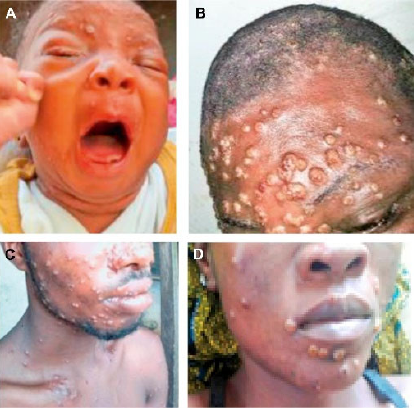
Figure 1. ( A – D ) Maculo ‐ papular ‐ vesicular ‐ pustular monkeypox skin lesions of varying sizes on the face. (Courtesy of Nigeria Center for Disease Control, Abuja, Nigeria.) Reprinted with permission from Ref. [33]. Copyright 2019 the Infectious Disease Clinics of North America.